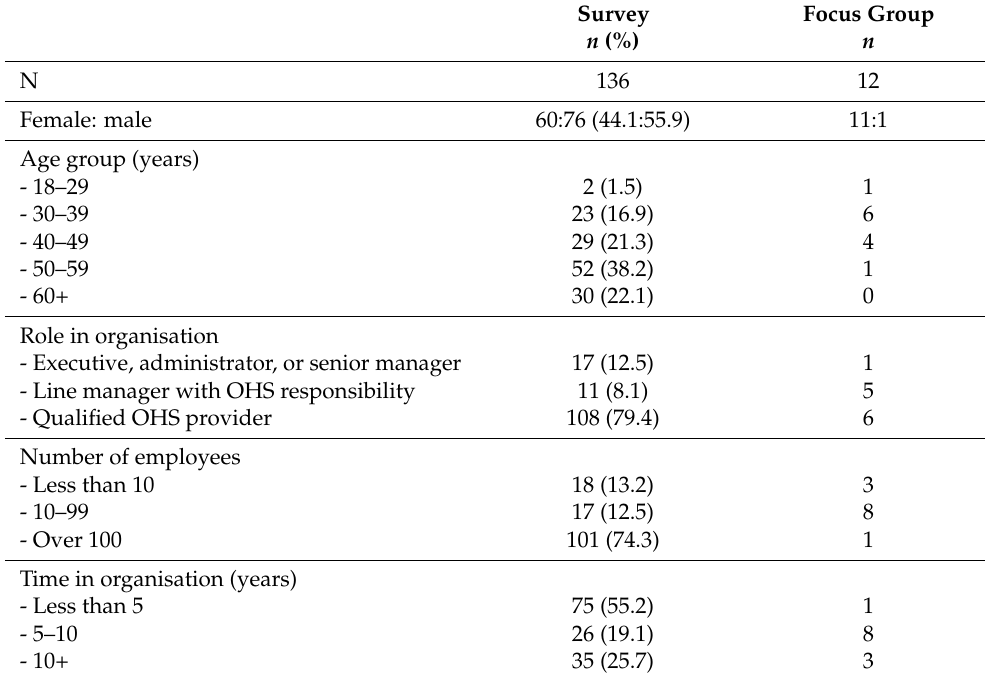
Table 1. AIHS participant profile for the survey and focus group.